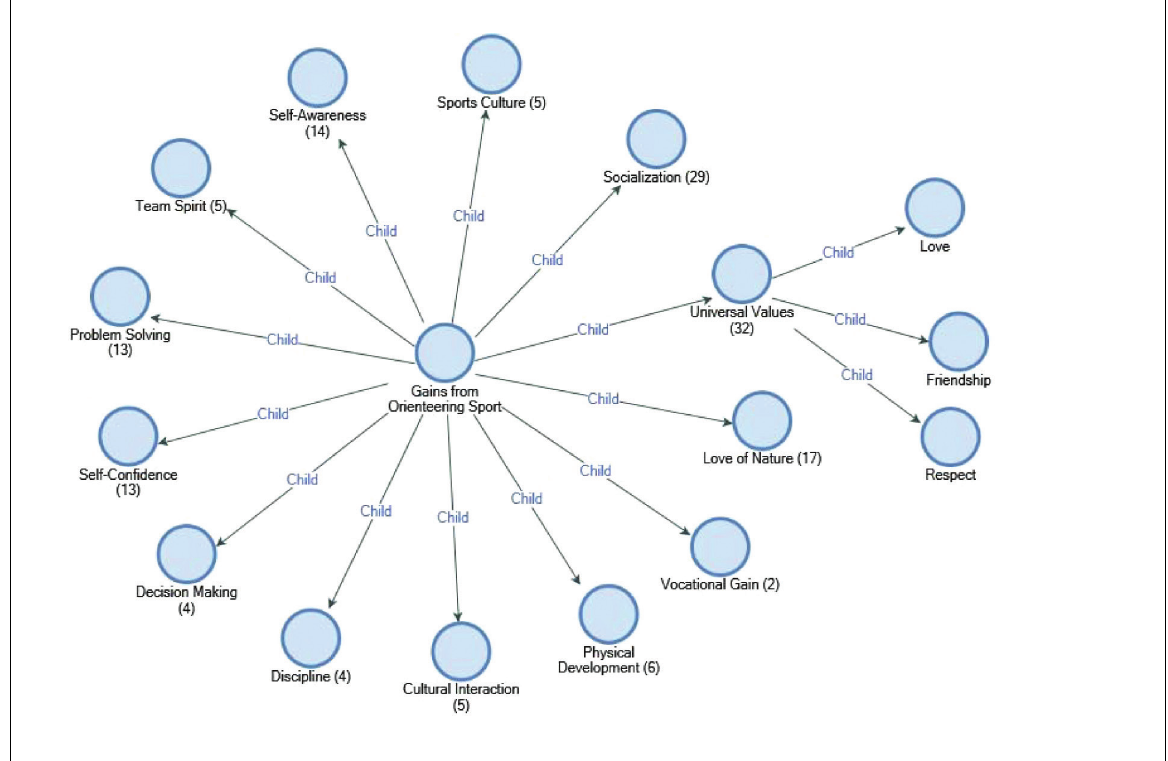
Figure 3. Themes, codes and statements about the gains of Orienteering sport according to the research participants’